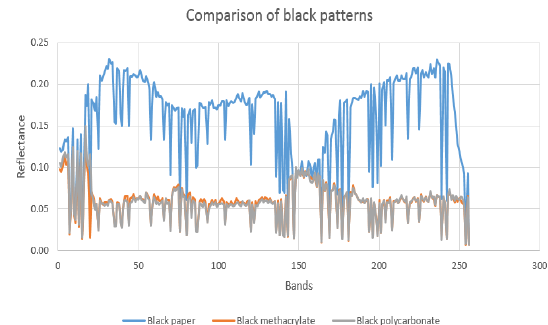
Figure 6. Comparison of the spectral signatures of the black patterns (normalization without ROIs)